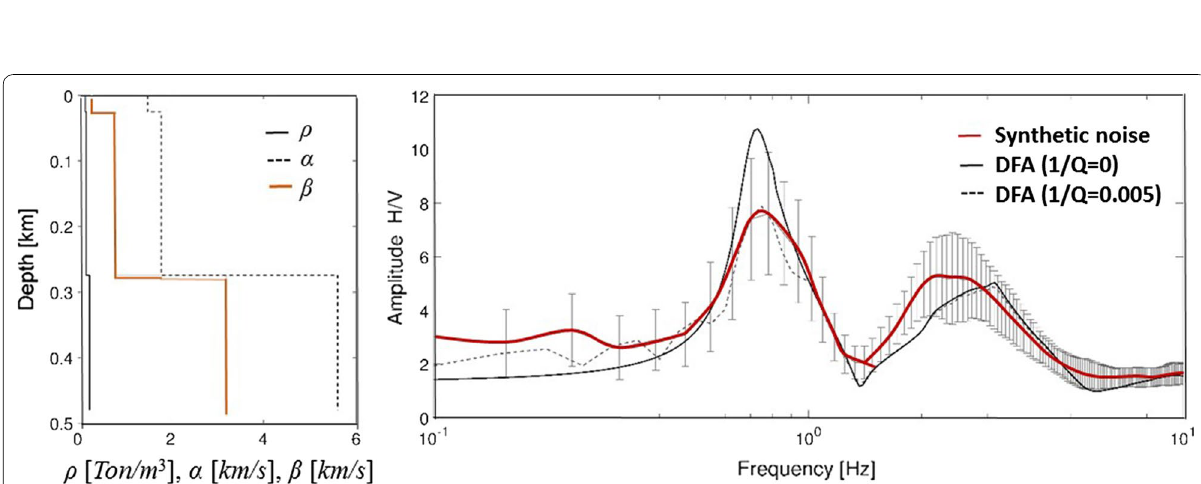
Fig. 3 ( Left ) Stratigraphy profiles of model N104 studied within the SESAME Project. ( Right ) Black line shows H / V computed at the surface of model N104 excited with synthetic noise. The bars indicate the standard deviation. With black continuous line and gray dotted line , the results of the compu‑ tations using the DFA with no damping (1/Q